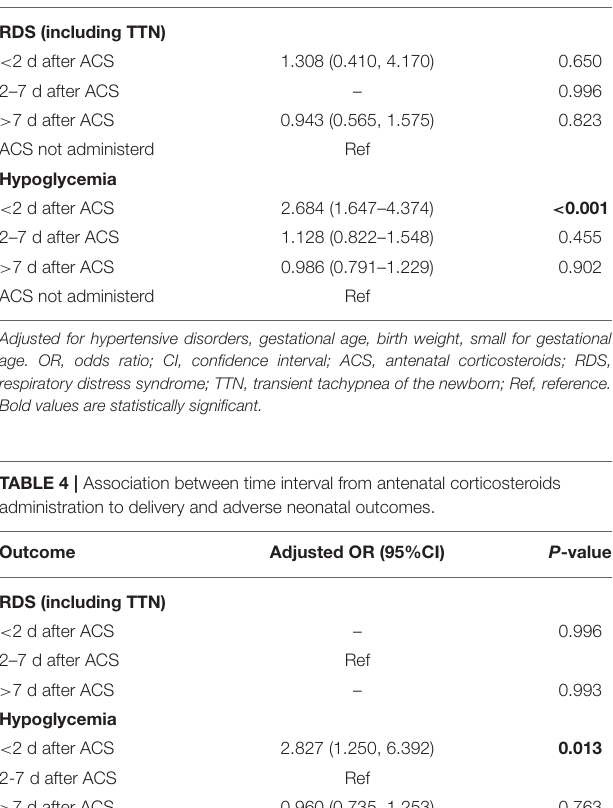
TABLE 3 | Association between time interval from antenatal corticosteroids administration to delivery and adverse neonatal outcomes. Outcome